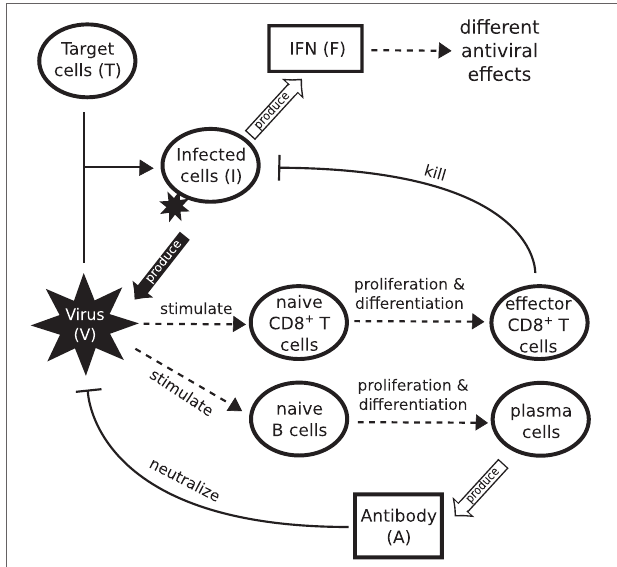
FIGURE 1 | Schematic diagram showing the major components of viral infection and the immune response . Infection starts when virus binds to healthy epithelial cells (target cells). Infected cells release new virus and produce cytokines such as IFN. IFN is a major driver of innate immunity, responsible for effective control of rapid viral growth and expansion. Virus further stimulates naive CD8 + T cells and B cells to produce effector CD8 + T cells and antibodies, responsible for final clearance of